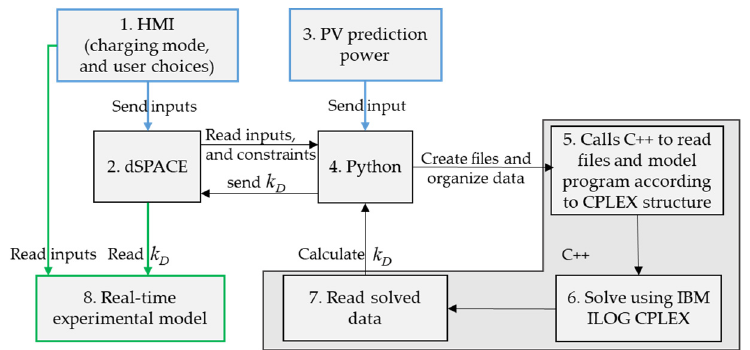
Figure 18. Flowchart of optimization solving.